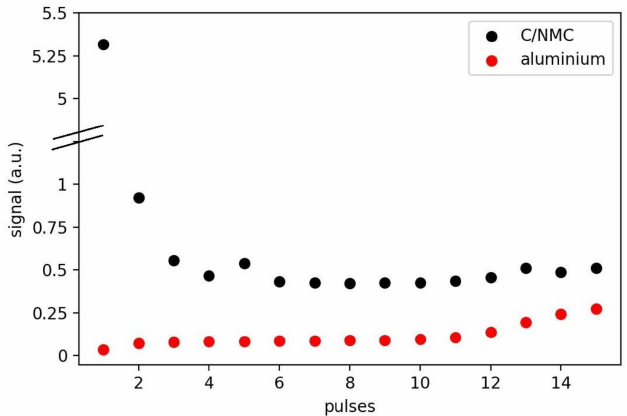
Figure 6. Signal of the carbon line divided by the NMC lines (black) and the aluminum signal (red) as a function of pulse number.